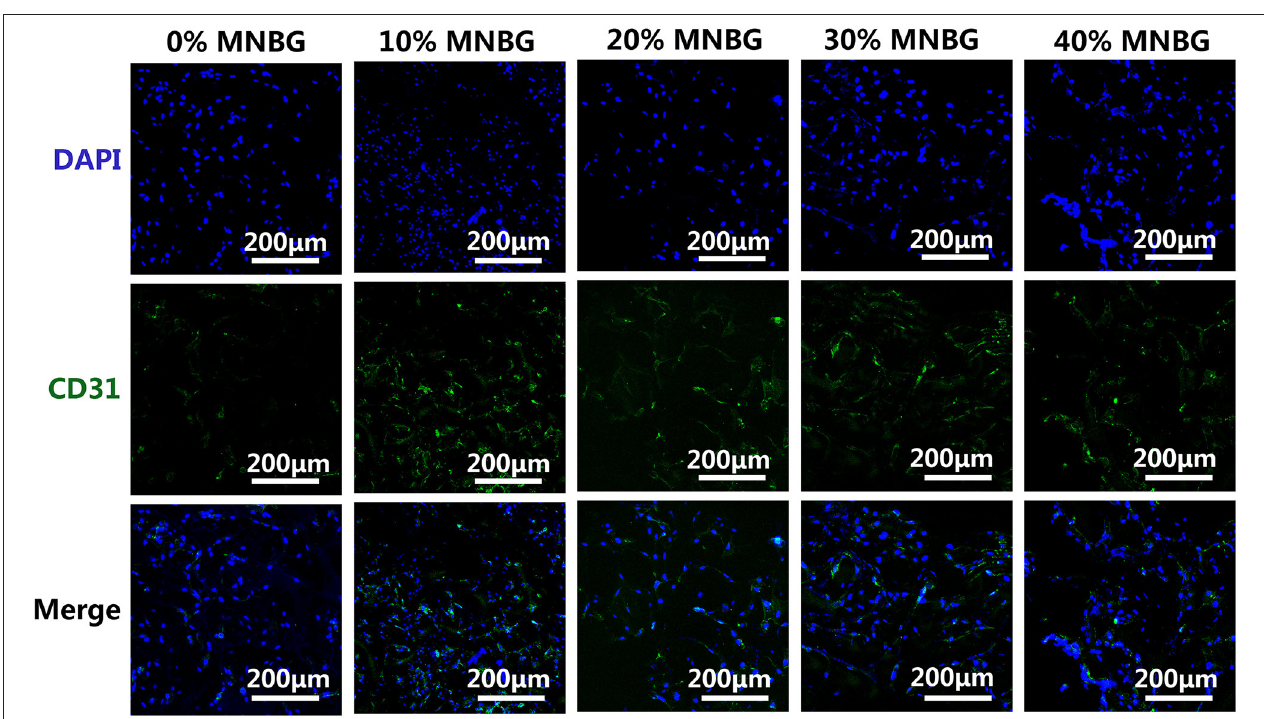
FIGURE 8 | Expression of CD31 in HUVECs by an immunofluorescence assay. Immunostaining images of CD31 (green) and DAPI (blue) for different scaffolds.